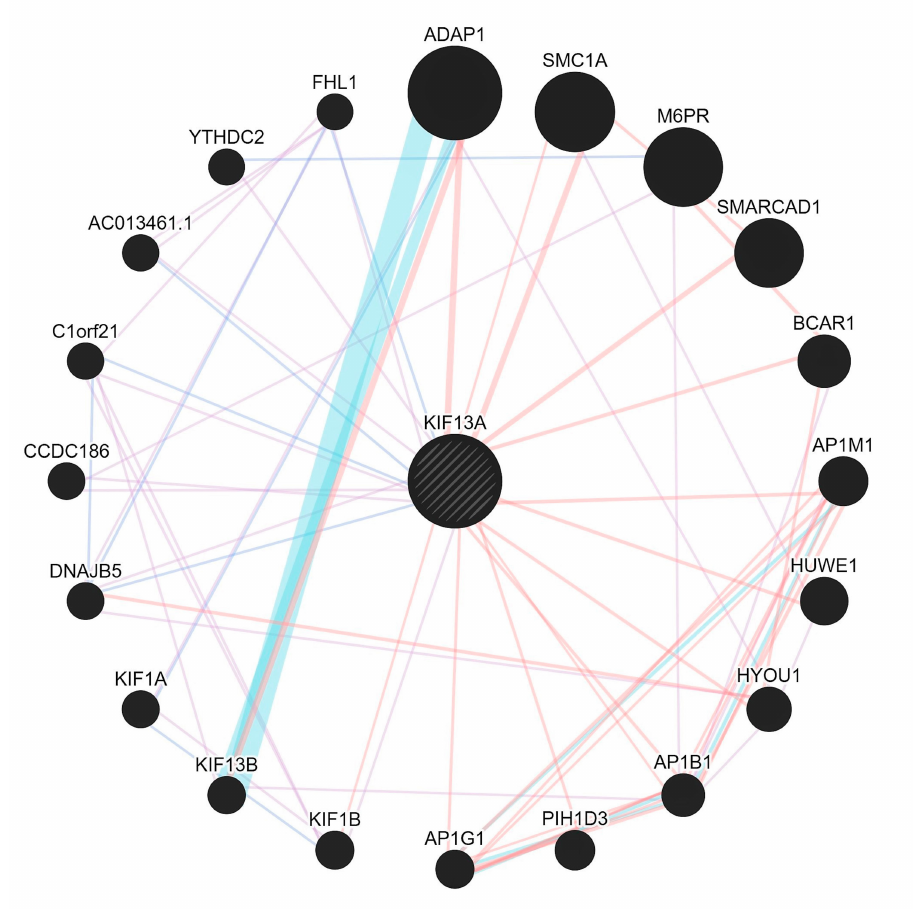
Figure 3. The pathway network map of KIF13A with pink edges (showing physical interactions), purple (co-expression) and violet (co-localization) and the blue thick edges showing the